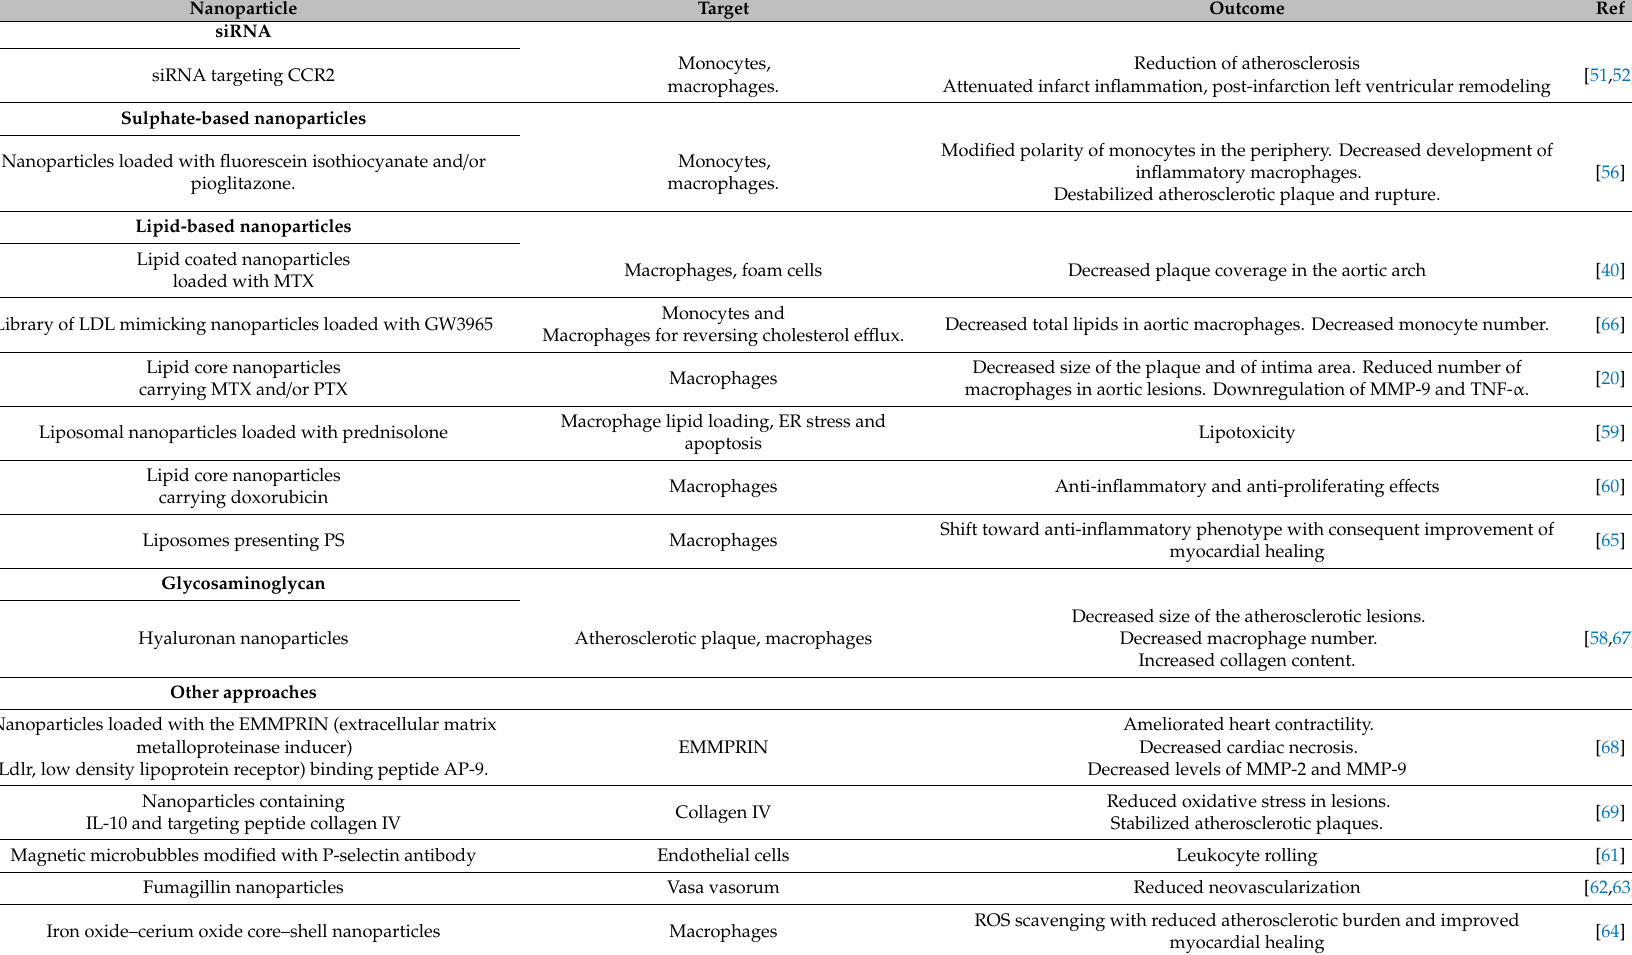
Table 1. Recent findings on the application of nanoparticles in the therapy of atherosclerosis and related